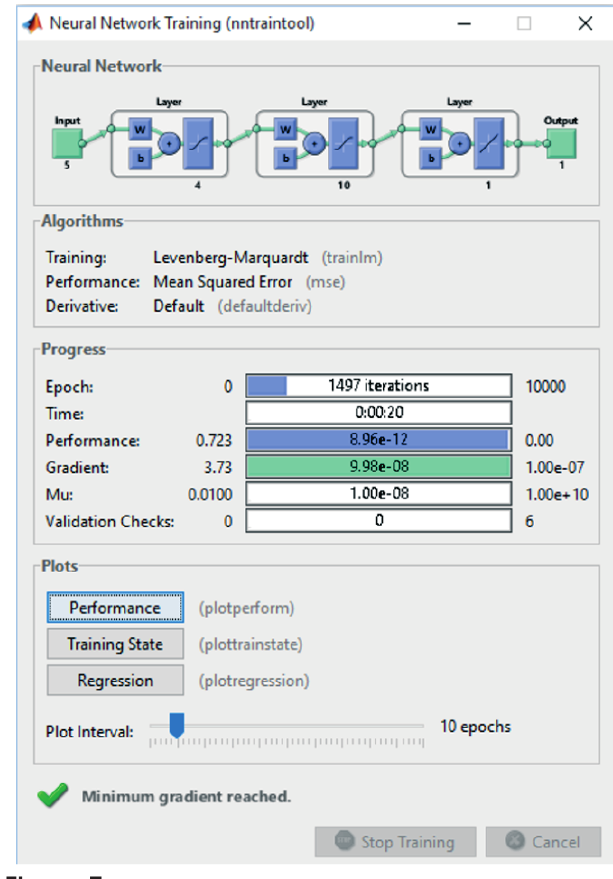
maximum adherence of pull-out tests used to compose the